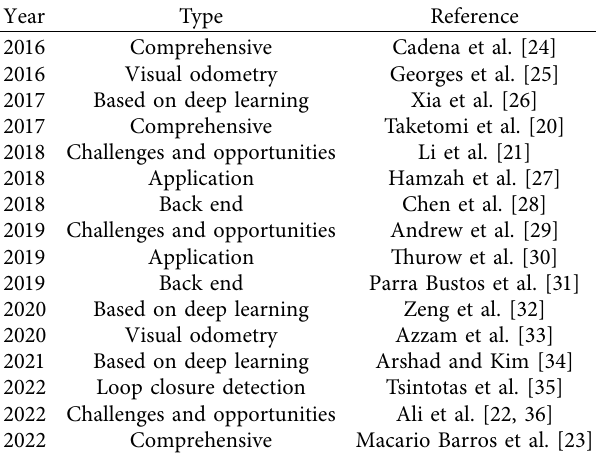
Figure 2: LIDAR price lists. Table 1: Classifcation of review papers in recent